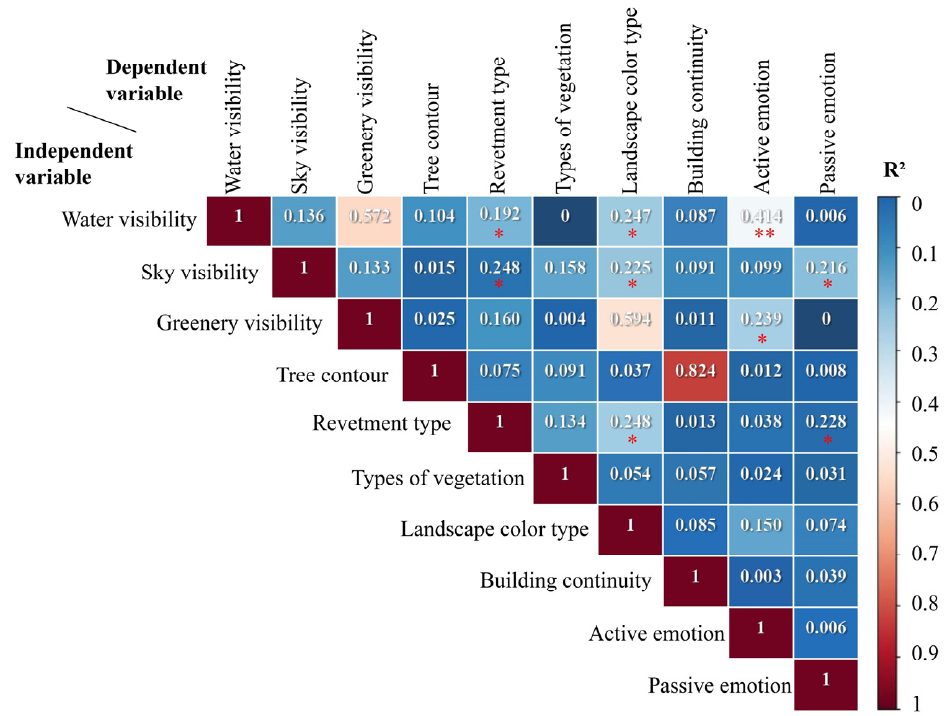
Figure 11. Curve estimation results (*** p < 0.001, ** p < 0.01, * p < 0.05, see Figure A2 in Appendix A).